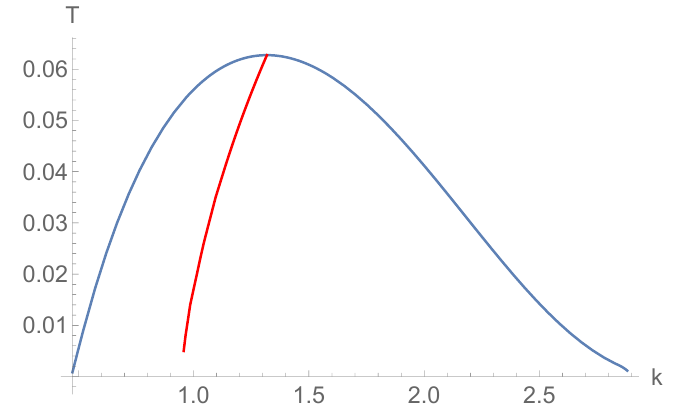
Figure 1 . Marginal modes (blue) and thermodynamically preferred solutions for (cid:13) = 1 : 7. Our results are in agreement with